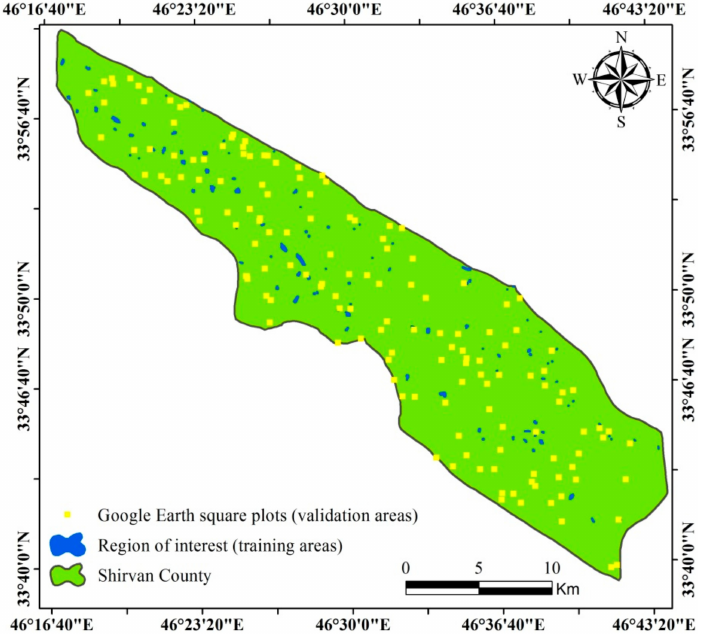
Figure 7. Location of region of interest (training areas) and 150 random square plots in Google Earth (validation areas) for accuracy assessment of land cover maps.